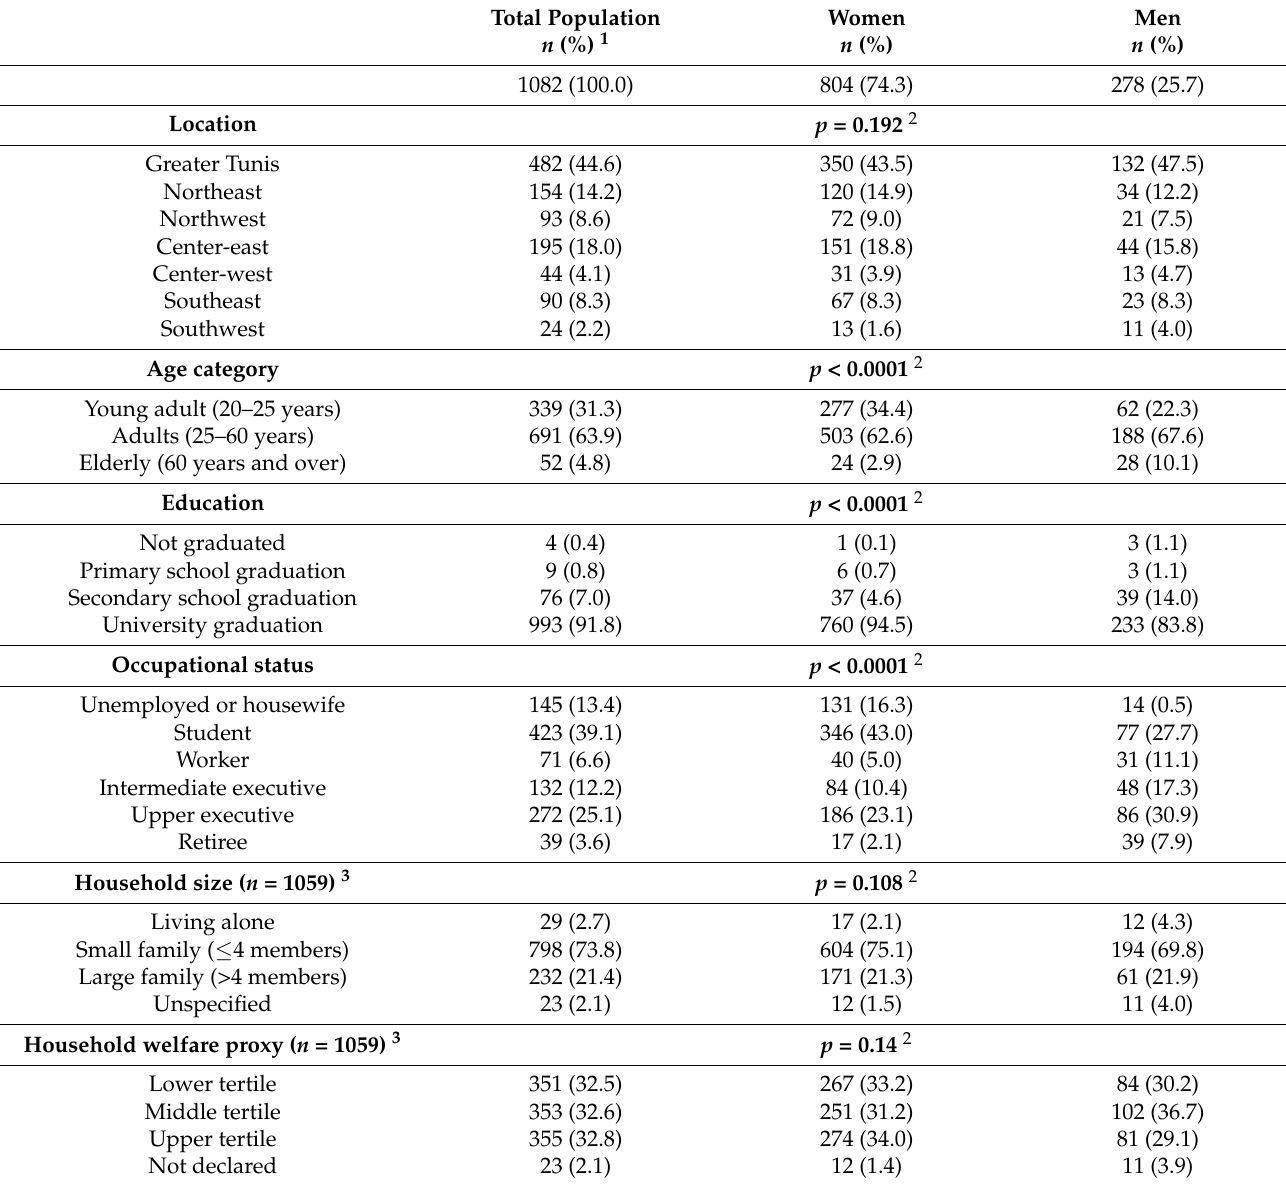
Table 1. Sociodemographic characteristics of the